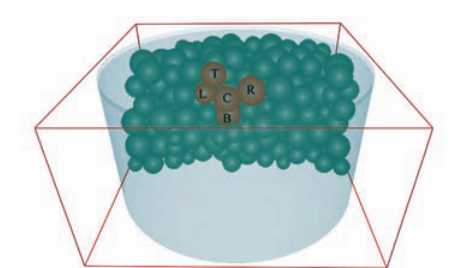
Fig. 12. Central vertical section of Sample 1 with marked particles